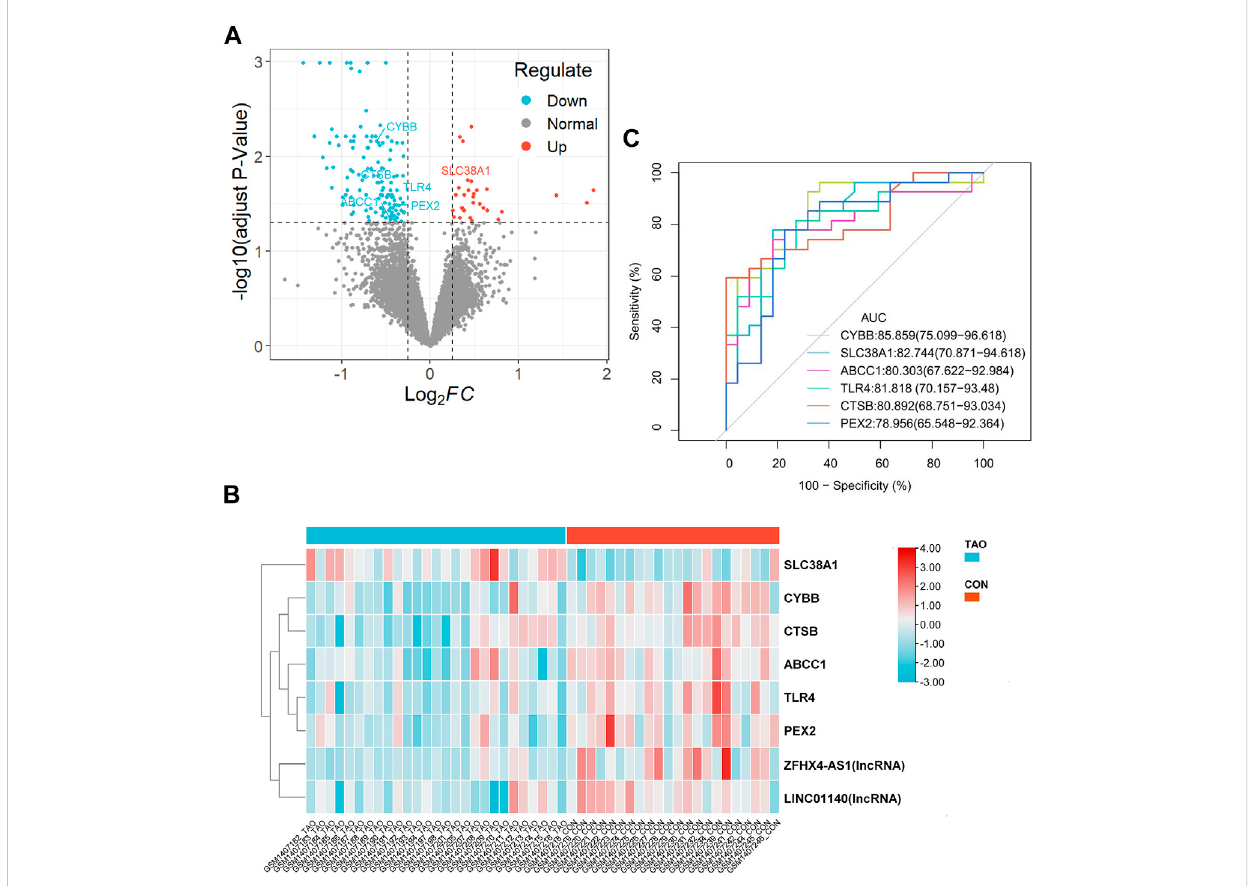
FIGURE 2 Identi fi cation of DEGs and differential expressed FRGs. (A) The vocanol plot of DEGs between TAO groups and health groups. The orange plots indicate upregulated genes and the blue plots indicate downregulated genes. (B) The heatmap of six differential expressed FRGs and two ferroptosis- related lncRNAs. The blue rectangles indicate low expression and the orange rectangle indicate high expression. (C) The ROC curve of six FRGs in the orbital tissue group from patients with TAO and the healthy controls in